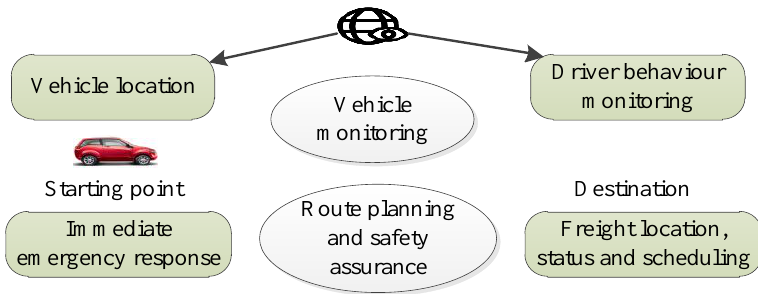
Figure 25. Real time emergency response in intelligent transport system.